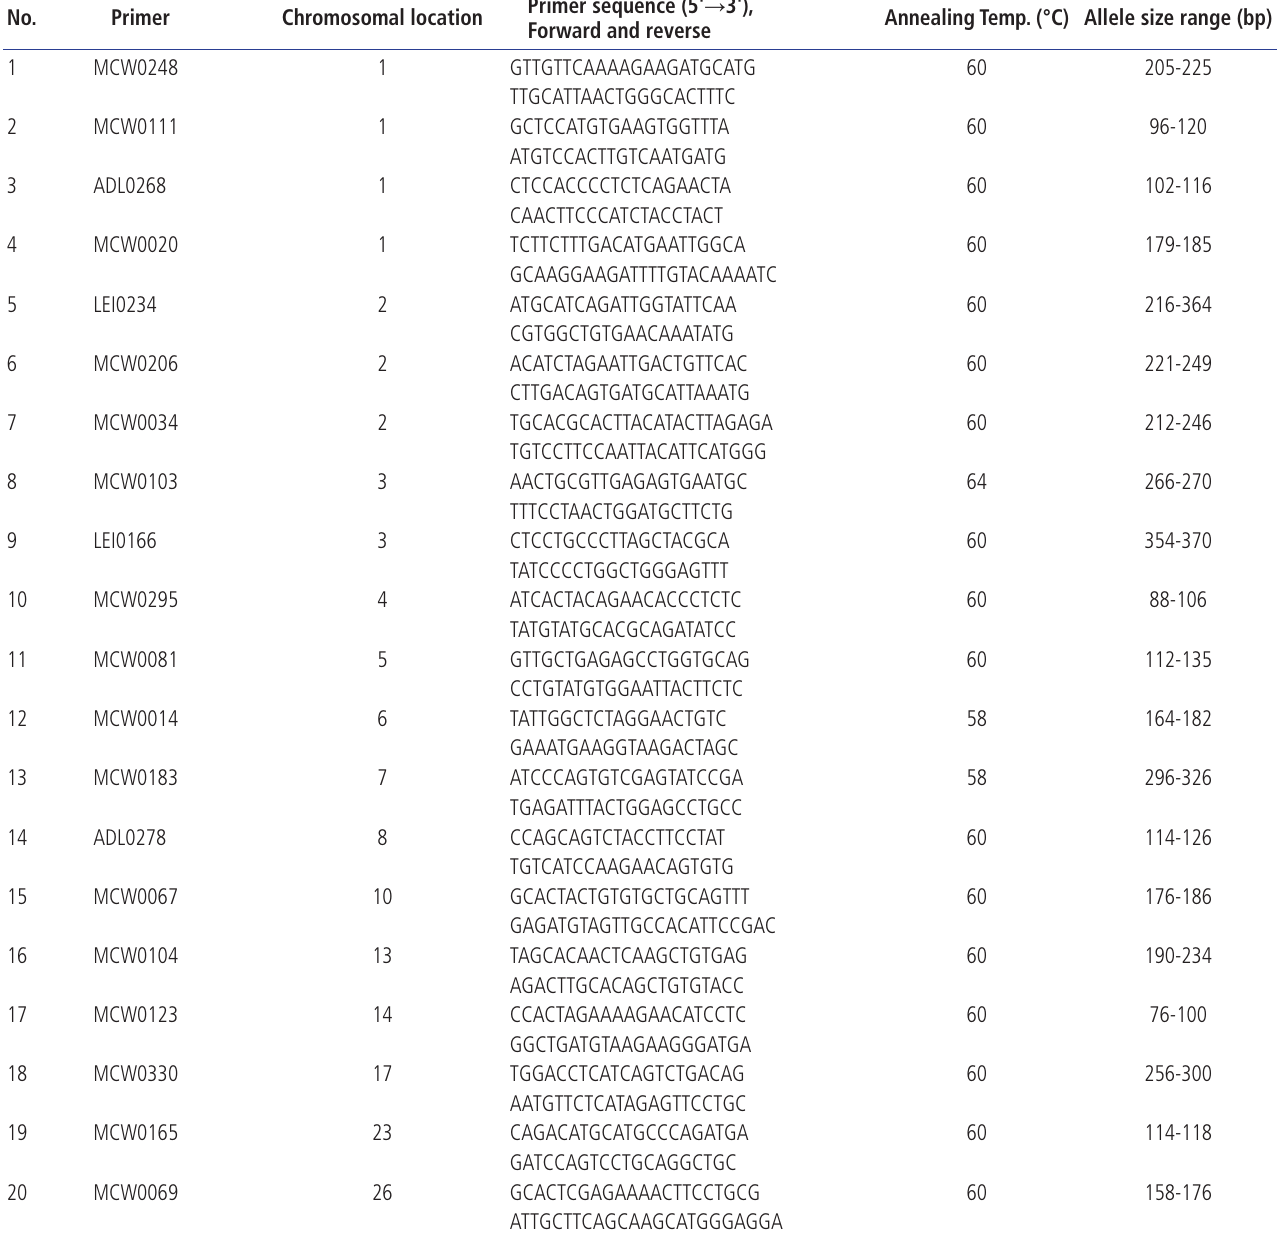
Table 2. Description of 20 microsatellite markers used in the current study No. Primer Chromosomal location